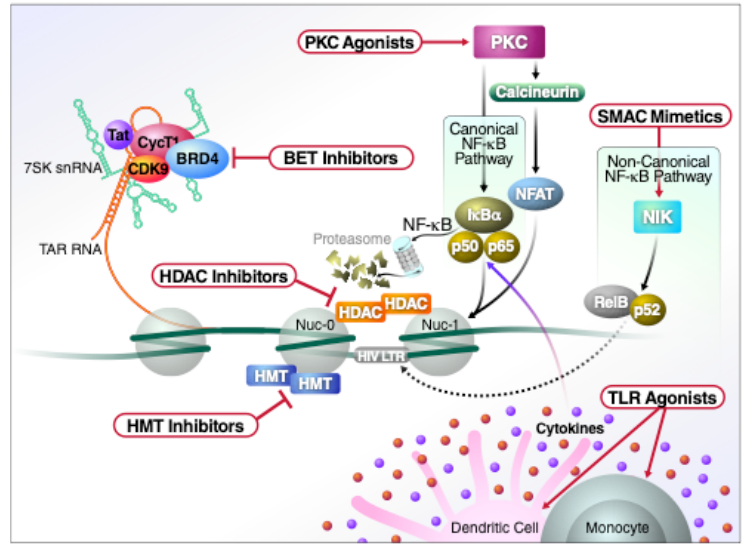
Figure 2. Schematic representation of the major classes of LRAs and their molecular mechanism of action.